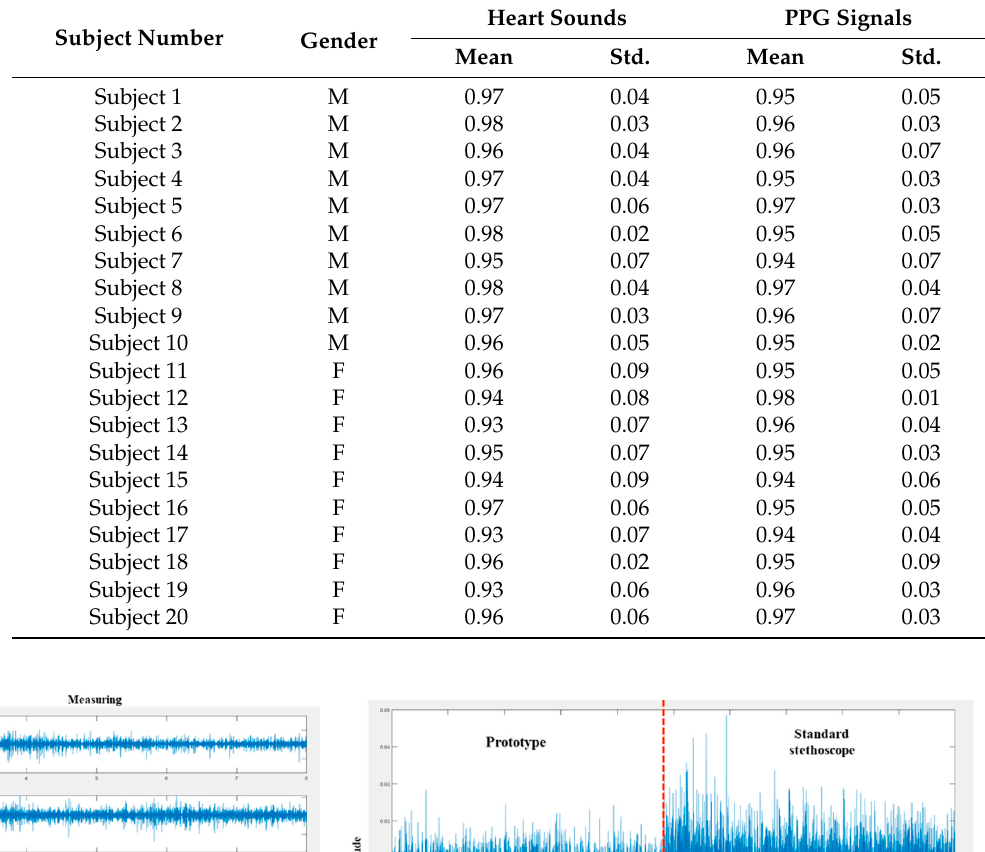
Table 1. Cross-correlation value of PCG and PPG signal measured by prototype and MP160 for 20 subjects.